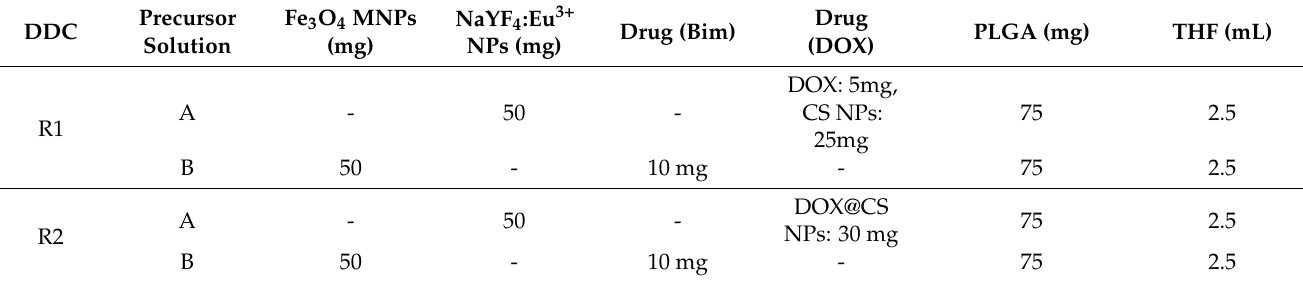
Table 2. Compositions of the precursor solutions for preparing R1 and R2